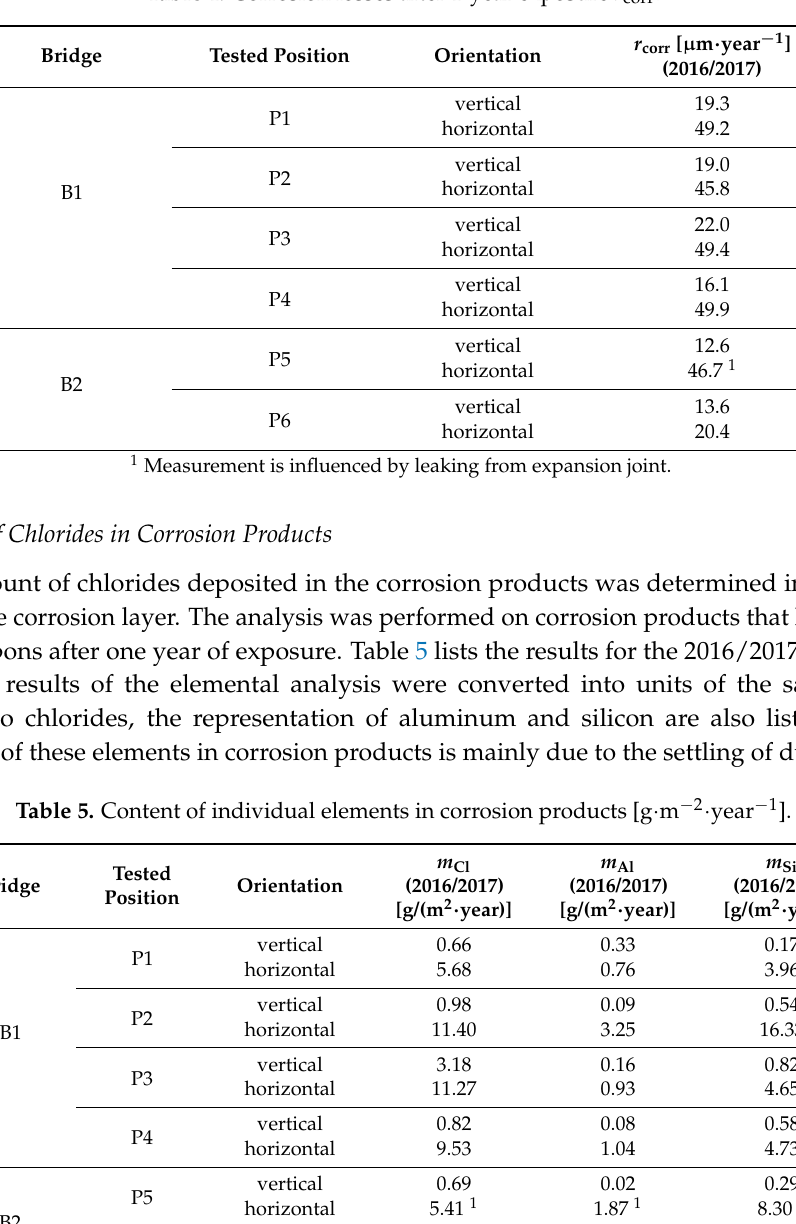
Table 4. Corrosion losses after 1-year exposure r corr .